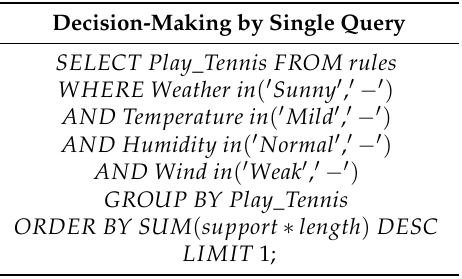
Table 8. The demonstration of the query used to classify the test